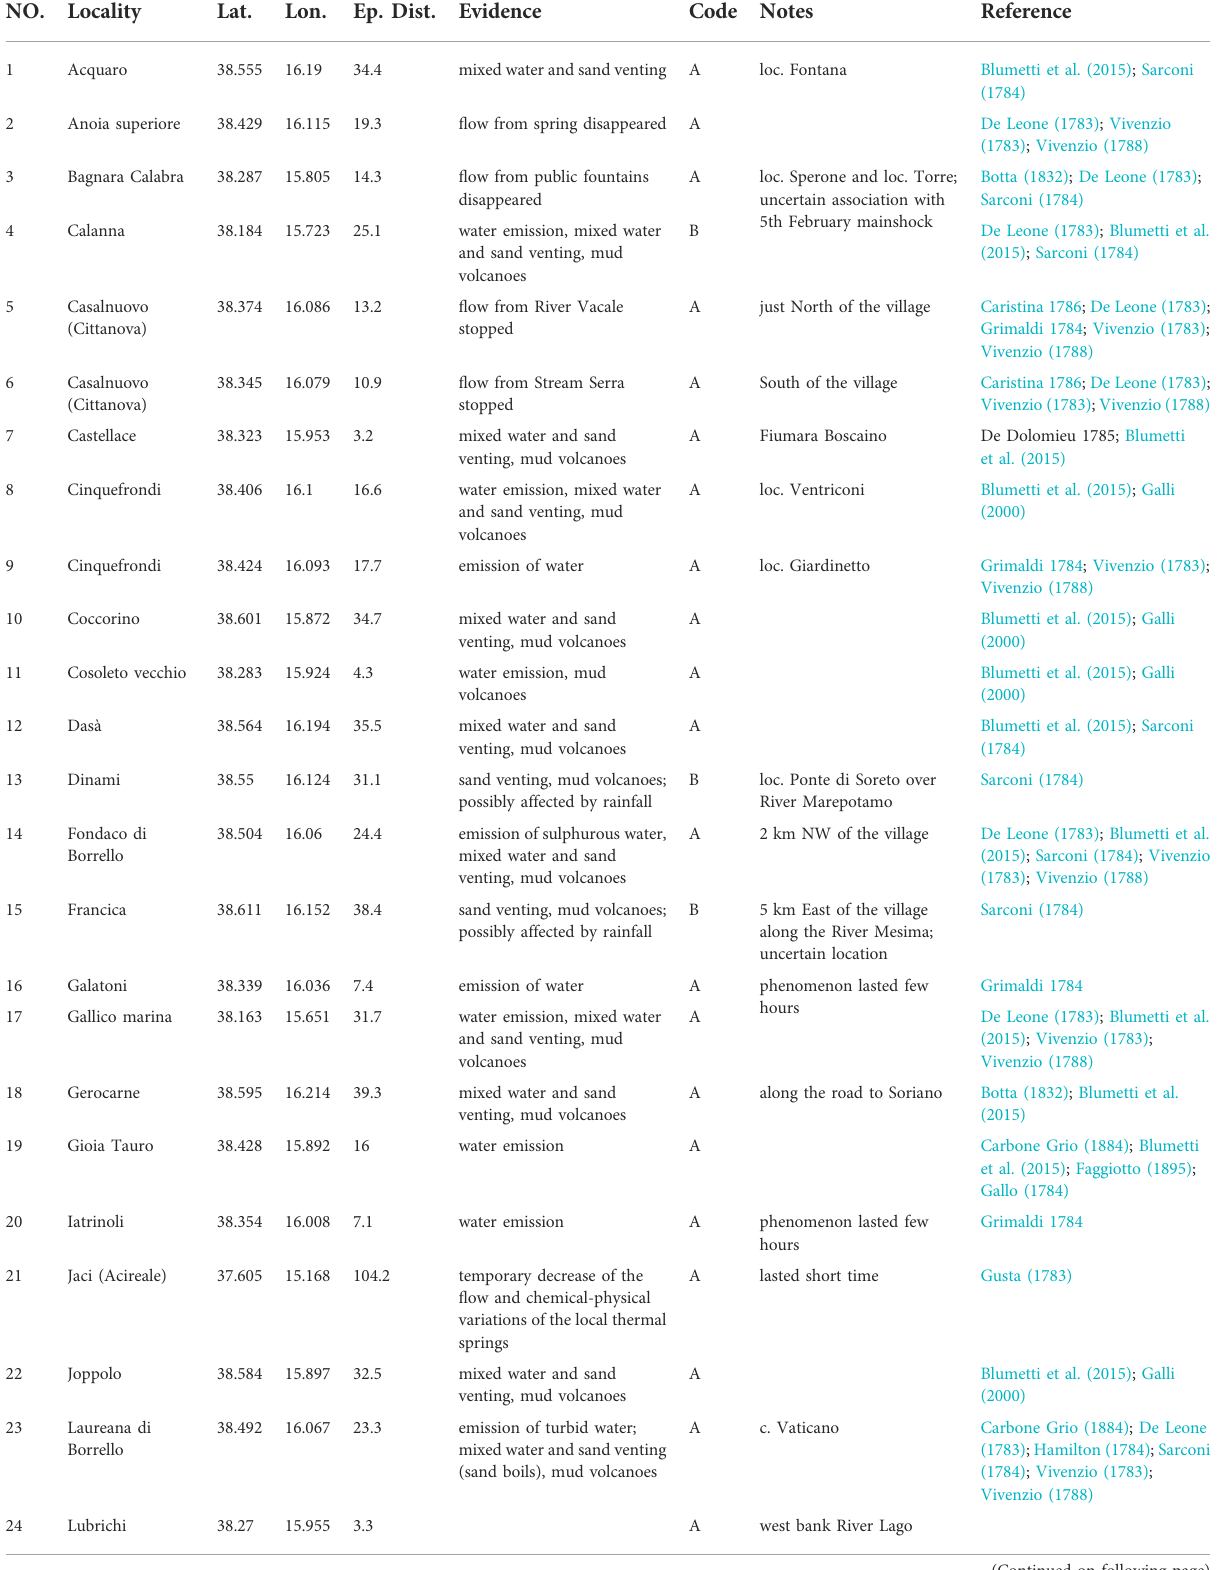
TABLE2Listofthehydrologicaleffectsassociatedwiththe1783earthquake(progressivenumbercorrespondstoFig.5).Theattributionofthequality codetothe 78effects isbasedonthe reliability of thereference/accountassociated with theobservation(see main text).The epicentral distance (in kilometers) is calculated from the location of the Italian seismic Catalogue (Rovida et al.,